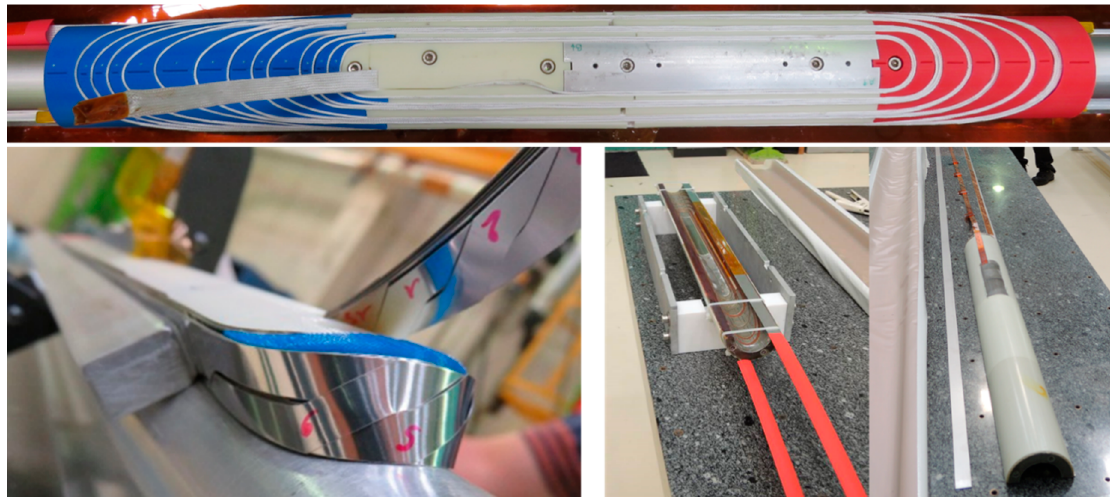
Figure 21. Top: practice winding of the CEA dipole with Roebel dummy cable (test with different end spacer concepts, the blue ones on the left have been finally chosen). Bottom left: detail of the cable turning during winding; center and right: pictures of the one of the three coils just after the impregnation (courtesy of M. Durante,